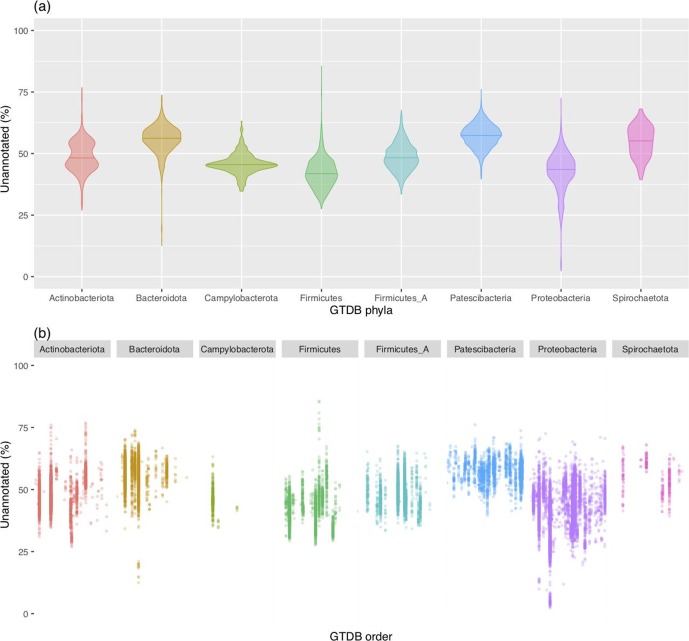
Distributions of genome annotation coverage subdivided by taxonomic group. Genomes were annotated using Prokka with default parameters (see Methods). Only the most common phyla from the GTDB [2] are shown. (a) Taxonomic separation by phyla. (b) Taxonomic separation by order. Labelled orders are using GTDB taxonomic nomenclature.